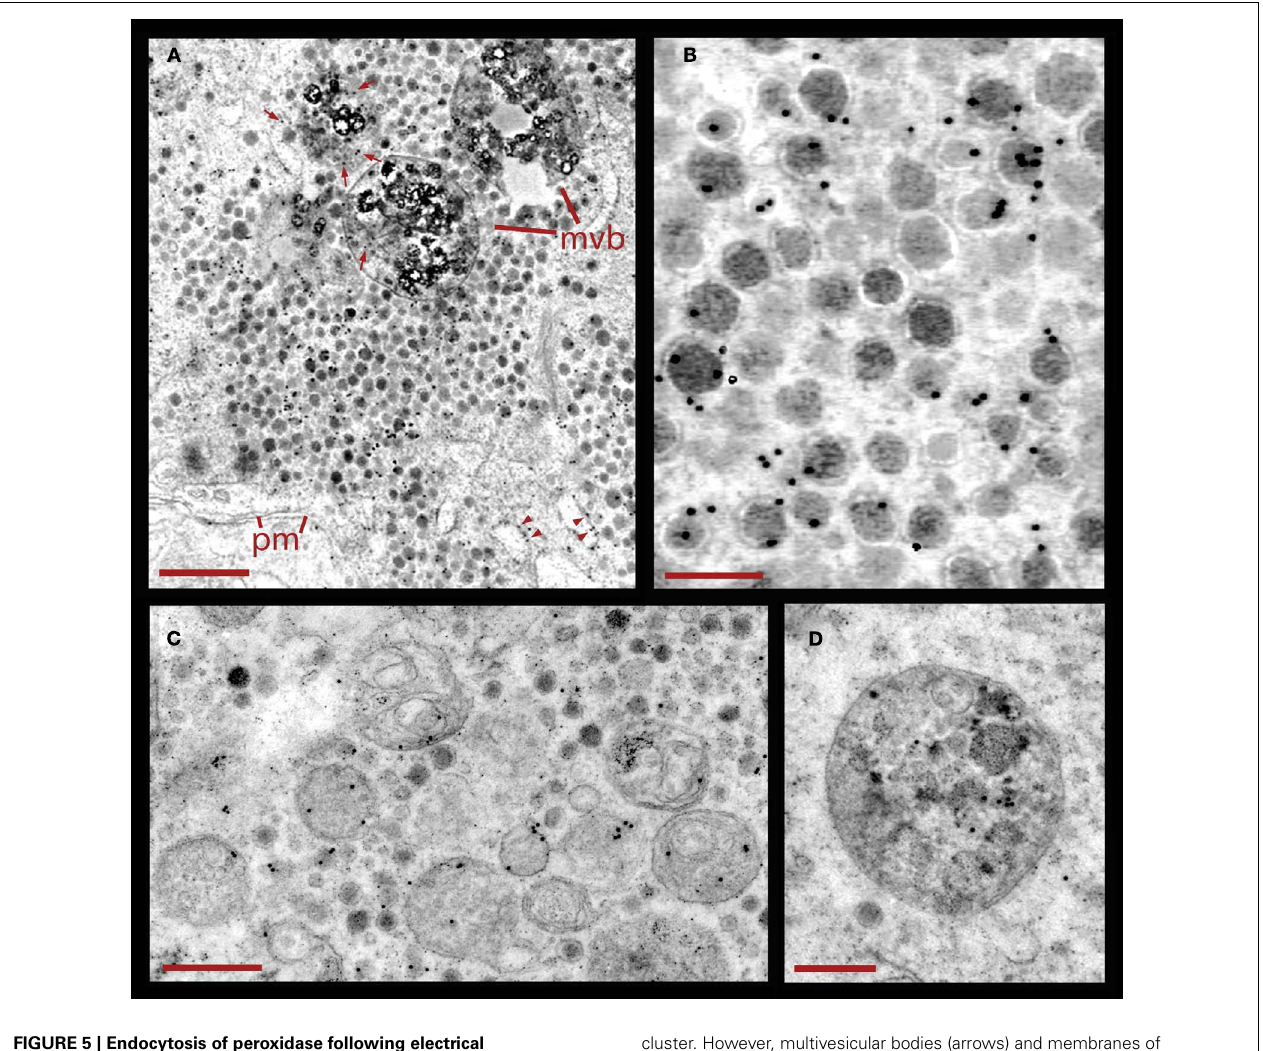
FIGURE 5 | Endocytosis of peroxidase following electrical stimulation. (A) Vesicle cluster in a neuron fixed during stimulation in the presence of external peroxidase. Large multivesicular bodies (mvb) are also present. Peroxidase was detected by a polyclonal antibody coupled to 10nm gold particles.The black electron dense spots are associated with vesicles in the clusters located near the plasma membrane (pm), and labeling was considerably lower outside of the